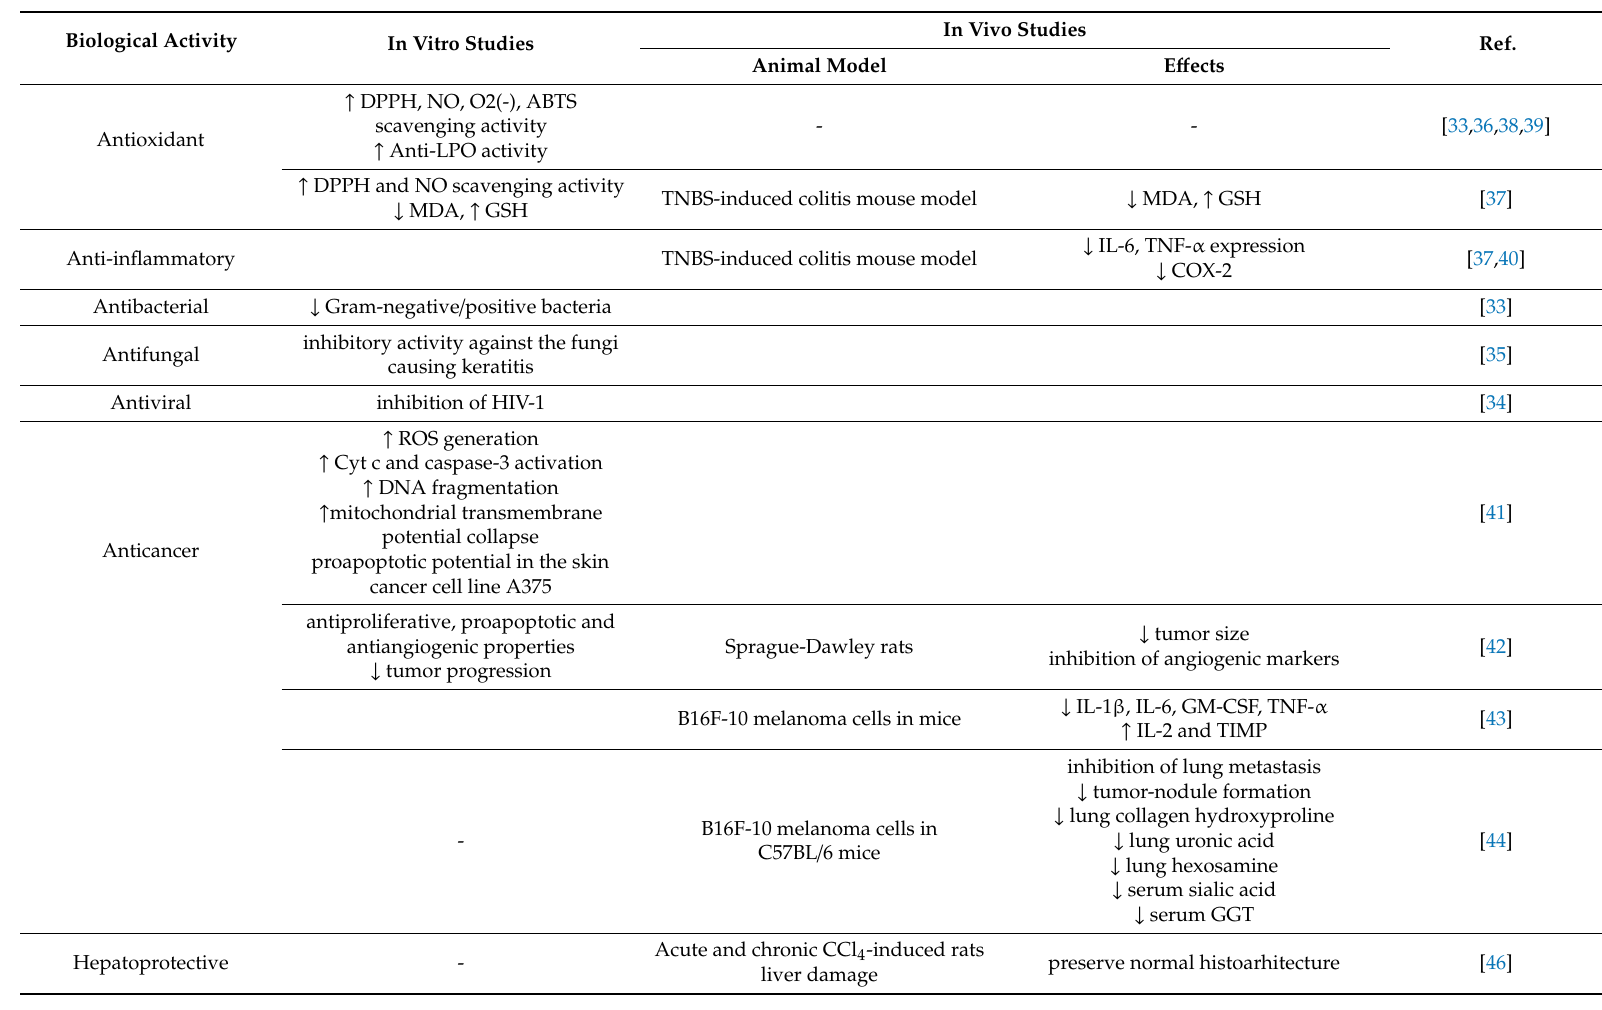
Table 3. Biological activities of the Thuja occidentalis shown by in vitro and in vivo